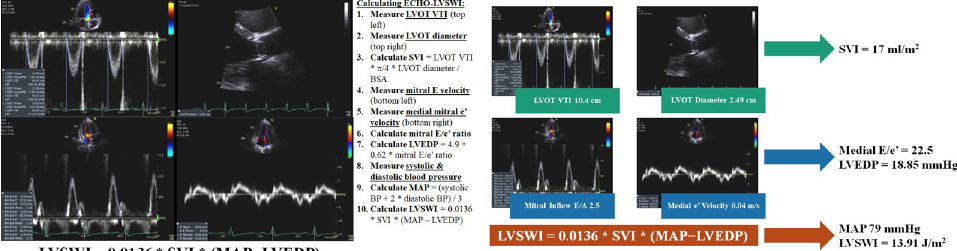
Fig 1. Calculation of the ECHO-LVSWI (left) and an example using TTE data from a patient with cardiogenic shock (right). The stroke volume index (SVI) is calculated using the left ventricular outflow tract (LVOT) velocity-time integral (VTI) by spectral Doppler, indexed to the body surface area. The LVEDP is estimated using the ratio of the peak mitral early diastolic (E) wave velocity by spectral Doppler to the peak mitral early diastolic (e’) wave velocity by tissue Doppler via the formula LVEDP = 4.9 + 0.62 � mitral E/e’ ratio [17,23]. We used the medial/septal mitral e’ velocity for this analysis, although our data suggest that either the lateral or mean e’ velocity could be substituted. The mean arterial pressure (MAP) was determined either invasively or noninvasively and estimated as (systolic blood pressure + 2 � diastolic blood pressure) / 3. We used the formula ECHO-LVSWI = 0.0136 � SVI � (MAP–LVEDP) [17,23].